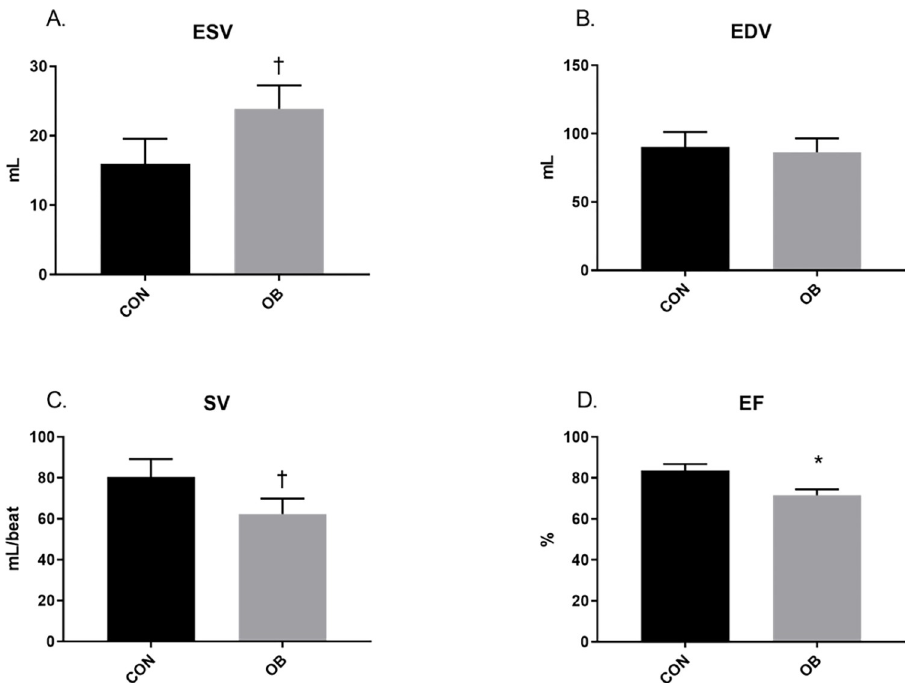
Fig 5. Echocardiography calculation results for 9-year-old ewes. CONF1 (n = 5) and OBF1 (n = 8) ewes. End- systolic volume (ESV). End-diastolic volume (EDV). Stroke volume (SV). Ejection fraction (EF). † means show a trend (p < 0.1). � means differ (p <